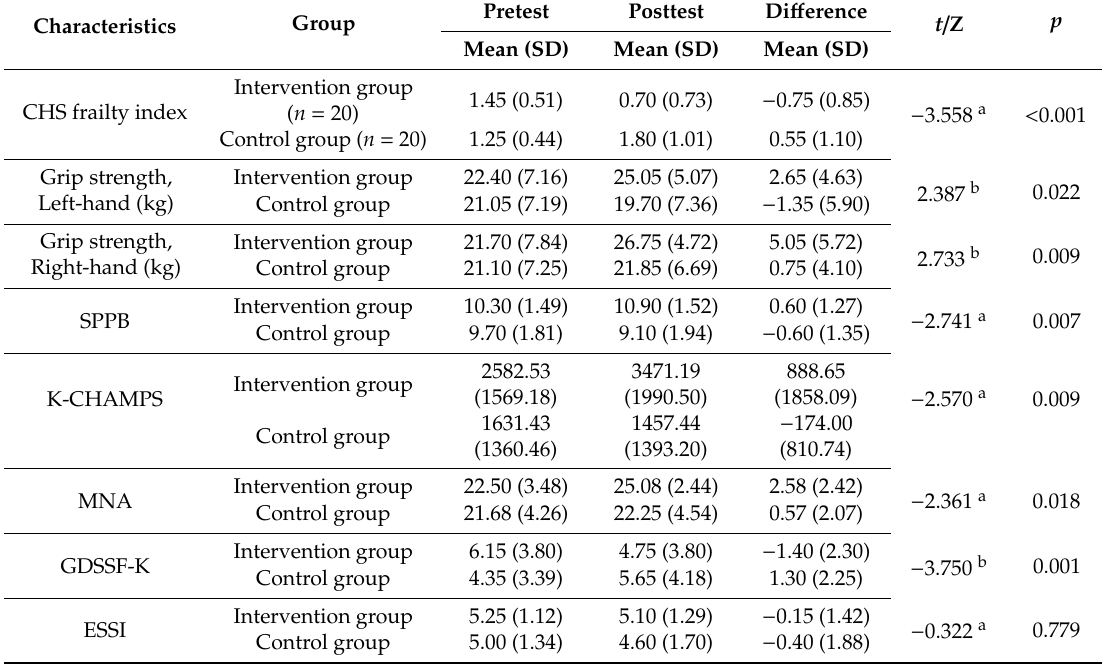
Table 2. Comparison of variables between the intervention and control